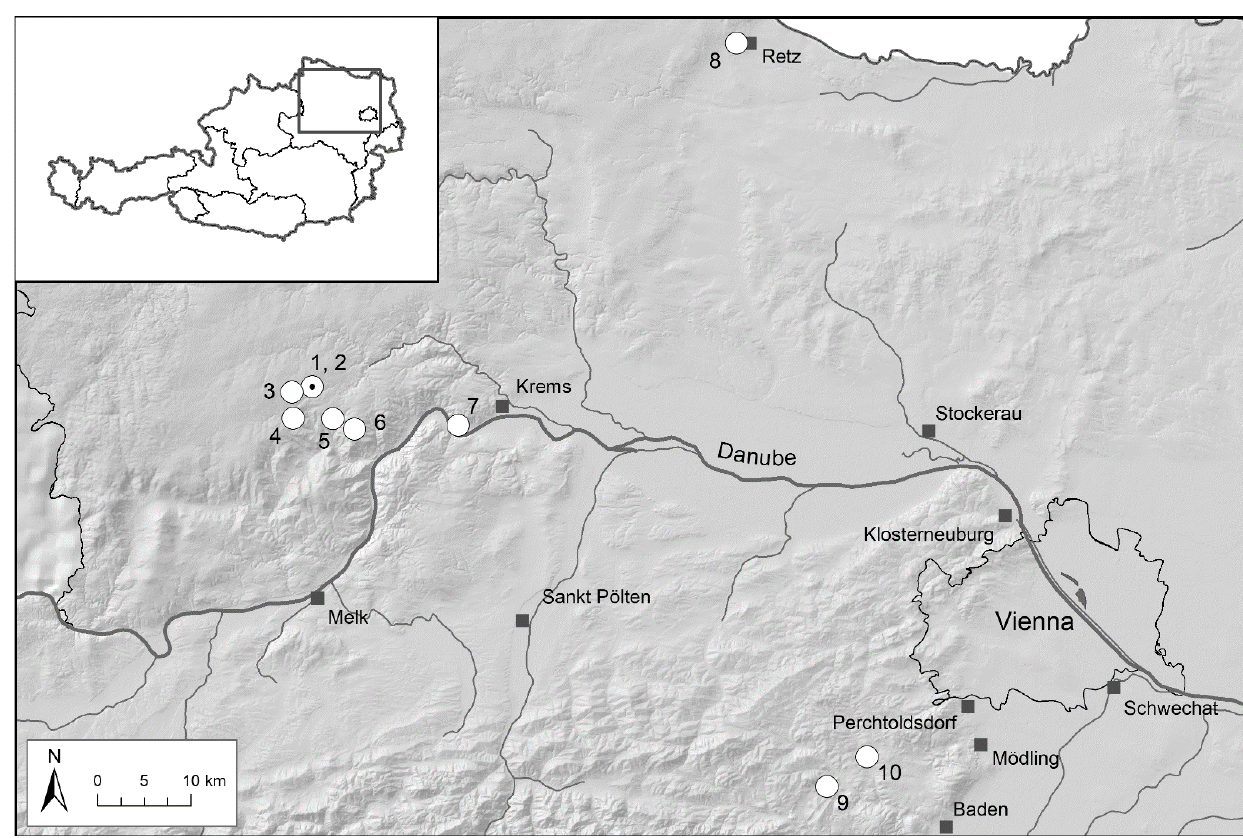
Figure 2. Locations (white circles) of the ten monitored Dactylorhiza sambucina populations in Lower Austria. The two nearby populations Voitsau I and II are marked by a dot within the white circle, as they could not be differentiated at this scale.